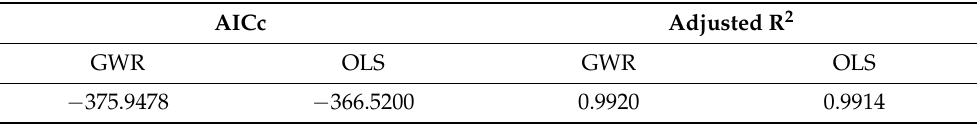
Table A6. The results of GWR and OLS analysis including the SPLIT and five selected independent